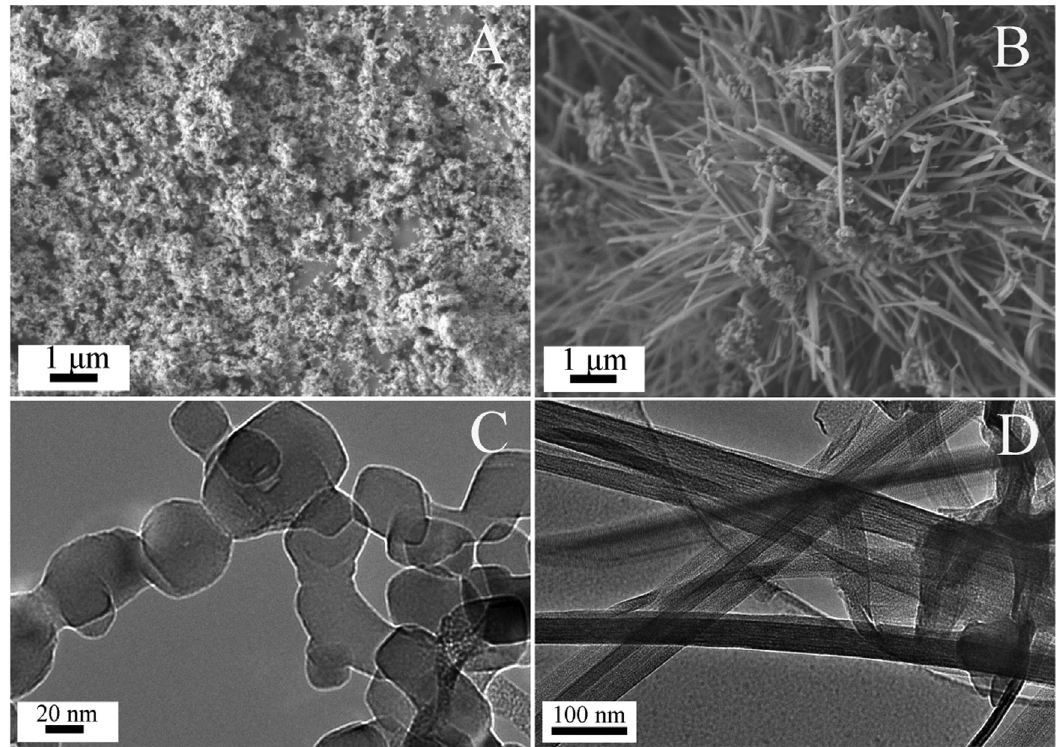
Figure 5 Typical scanning electron microscopy (SEM) images of the product synthesized from different positions of the plasma system: the discharge quartz tube (A) and the quenching chamber (B), corresponding transmission electron microscopy (TEM) images (C) and